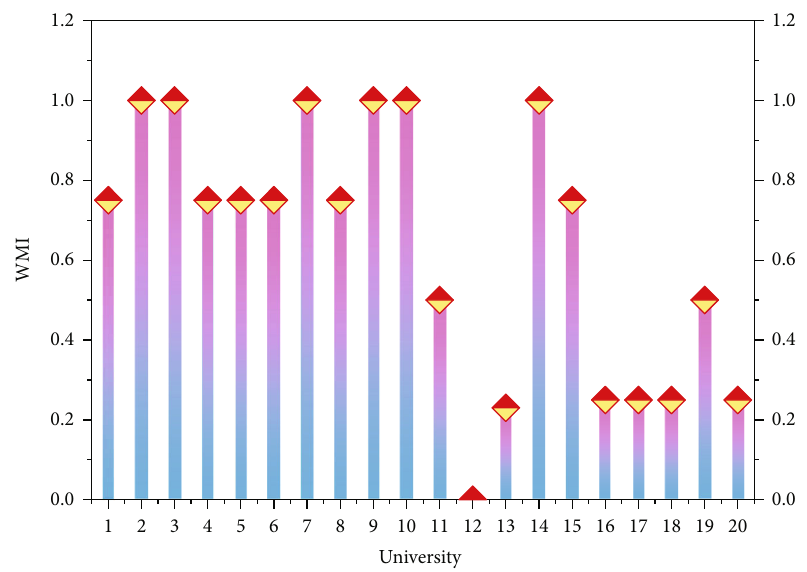
Figure 10: The standardized results of